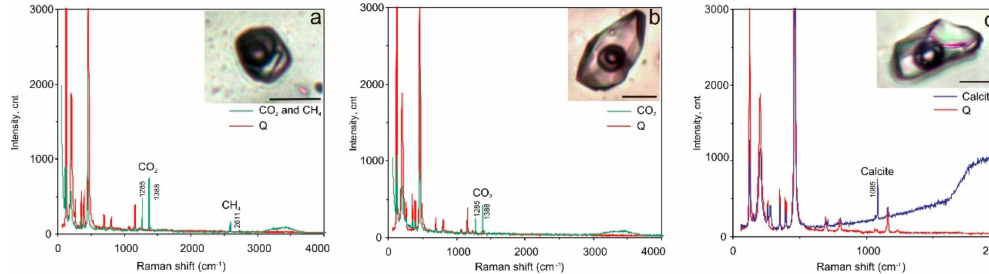
Figure 7. Fluid inclusions (FIs) with native sulphur in quartz from marble: ( a )—multi-phase FIs, ( b )—four-phase FIs with CO 2 , ( c , d )—gaseous FIs with dense CO 2 , ( e )—Raman spectra of FI showing the presence of sulphur. L—aqueous solution. Sample SV.